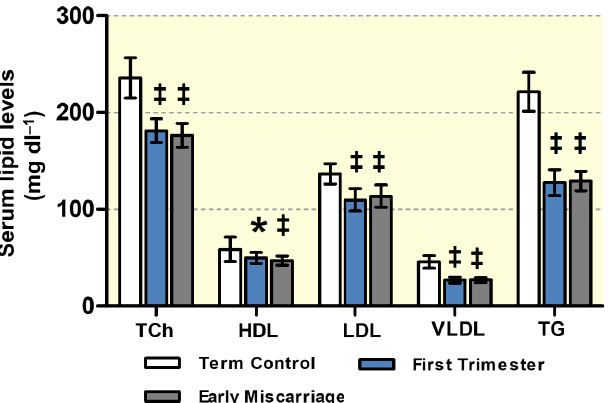
Figure 1. Maternal serum lipid concentrations . Total cholesterol (TCh), high-density lipoprotein (HDL), and triglycerides (TG) were determined in the serum of term controls, first trimester controls, and early miscarriage patients ( n = 19, n = 20, and n = 20, respectively) by using standard direct enzymatic – colorimetric assays. Low-density lipoprotein (LDL) and very low-density lipoprotein (VLDL) cholesterol were calculated from Friedewald’s equation by using TCh , TG, and HDL lev- els. Data are presented as mean ± SD for each group. No statistically significant differences between first trimester and early miscarriage (EMC) were found. Statistical analysis was performed by using Kruskal – Wallis test followed by Dunn ’ s multiple comparison test; ‡ ( p ≤ 0.001), * ( p ≤